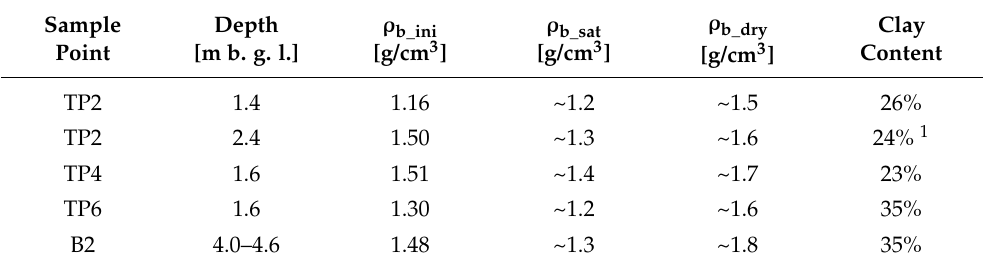
1 Clay content linearly interpolated between the determined values at 1.4 m and 2.9 m b. g. l.